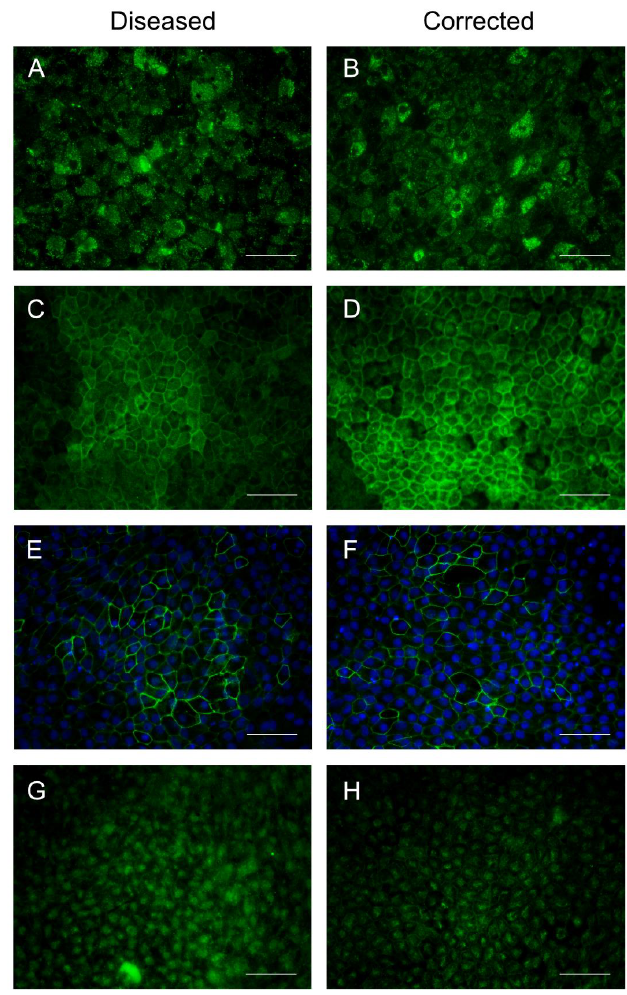
Figure 3. Localization of RPE-specific proteins at passage 3 on day 30. Immunocytochemistry revealed proper localization of RPE-specific proteins and PRPF8 (40× objective): ( a , b ) premelanosome 17; ( c , d ) bestrophin 1; ( e , f ) zonula occludens; ( g , h ) PRPF8. Scale bars are 50 µm.